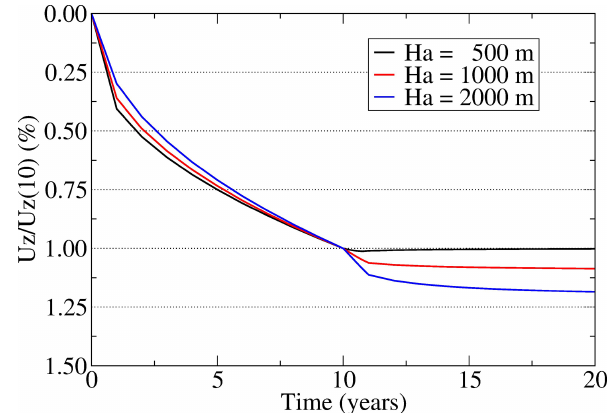
Figure 6. Maximum vertical displacement U z normalized with re- spect to the displacement at the end of the pumping period (10 years) U z (10) in the case with (cid:49)S s = 10m C r = 8, R k = 1 × 10 − 6 and H a = 500m, 1000m and